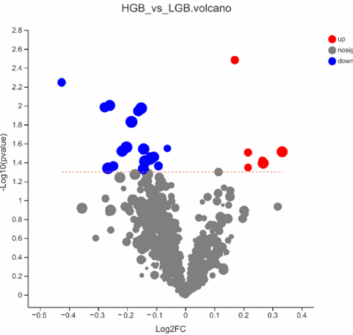
Figure 3. Differential metabolite analysis. Volcano plot: the abscissa is the multiple change value of metabolite expression difference of HGB vs. LGB, and the ordinate is the statistical test value of metabolite expression difference. The higher the ordinate value, the more significant the expression difference is. Each point in the figure represents a specific metabolite, and the size of the point represents the VIP value. Table 1. The six metabolites in the positive and negative modes obtained by Student’s t -test and KEGG pathway